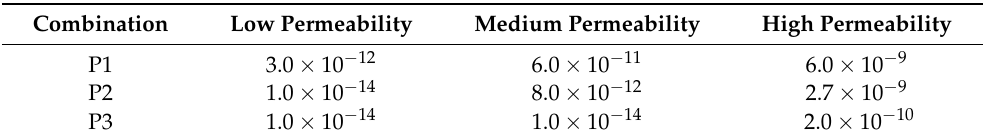
Table 3. Permeability values α i [m 2 ] for the three porous baffle sections for combinations P1, P2 and